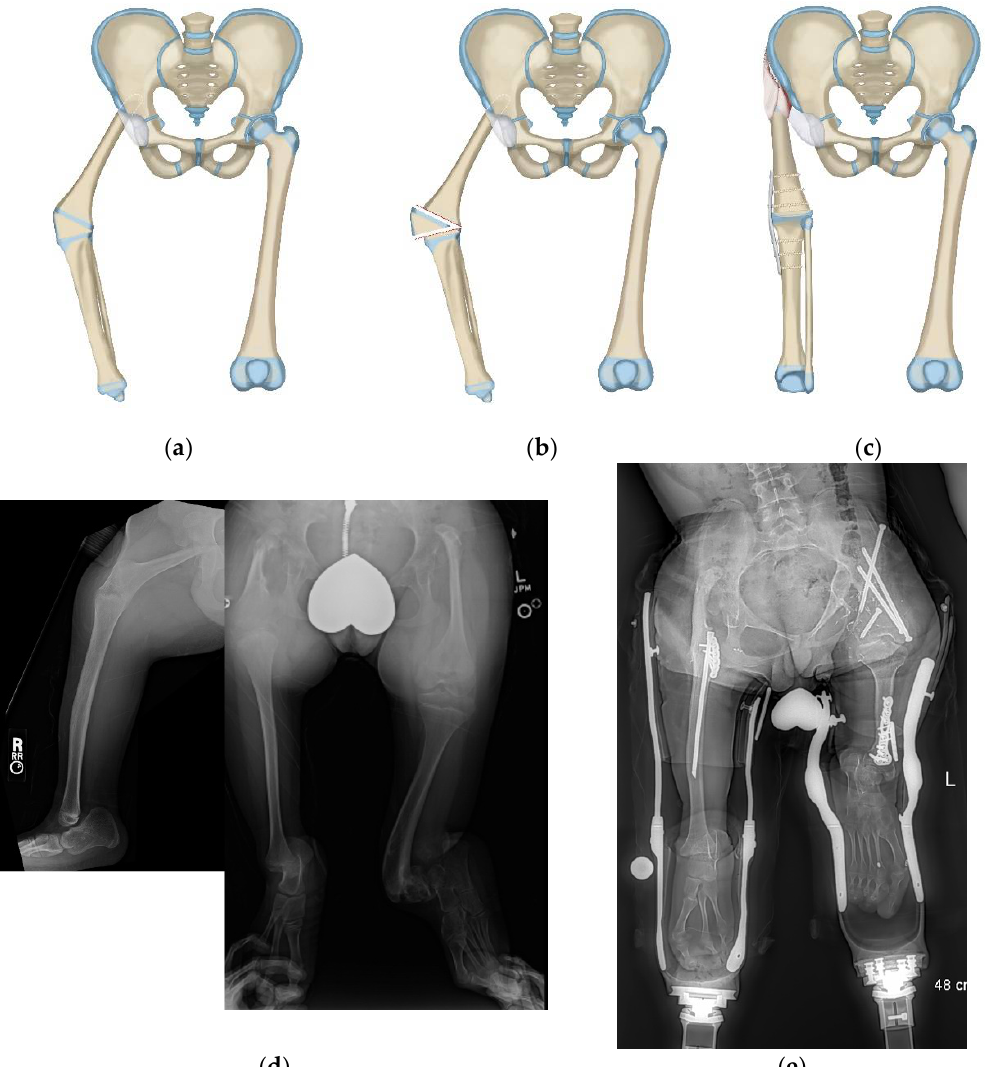
Figure 7. ( a ) Illustration of CFD type 2c with congenital knee fusion with knee flexion deformity. The fibrous femoral neck anlage tethers the upper femur from migrating proximally. ( b ) Illustration showing the first step which is correction of knee flexion deformity with excision of distal femoral physis. ( c ) Illustration of the second step which is PaleySling–Van Nes rotationplasty. The rotationplasty is performed through the knee fusion site. The proximal femur is stabilized using the fascia lata by creating a sling around the proximal femur. The sling plus the fibrous neck anlage stabilize the upper femur from migrating proximally and while preserving the hip flexion-extension mobility ( d ) AP long radiograph (right) of a 14-year-old boy with bilateral CFD. The right side is classified as type 2c and also has a congenital knee fusion as seen on the long lateral radiograph (left). On the left side it is classified as a CFD type 3b and the knee joint is present and functional. ( e ) Standing long radiograph one year after bilateral rotationplasty performed in two separate surgeries. On the right side the rotationplasty was performed through the congenital knee fusion site together with a sling procedure at the hip (PaleySling–Van Nes). On the left side a Paley–Brown rotationplasty was performed together with a supramalleolar osteotomy for